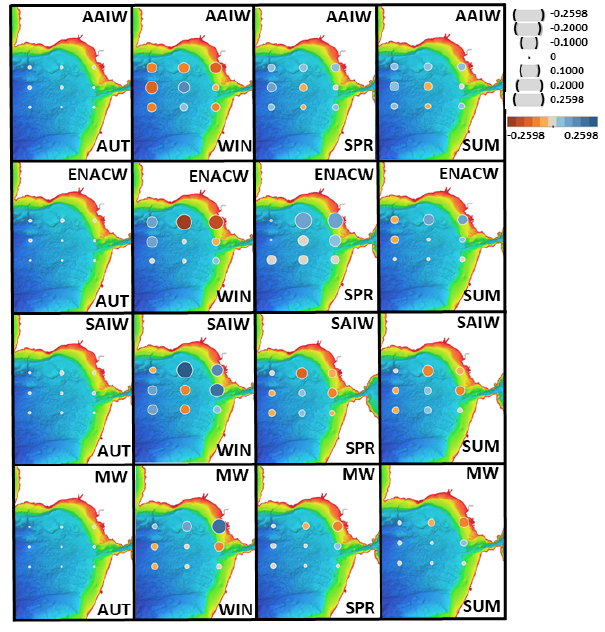
Figure 7. Seasonal variation of the percentages of each water mass given by the first principal component resulting from the PCA on the percentages previously estimated in the nine boxes considered in the GoC. Values are deviations from the averaged, through the different seasons, percentage at each location.